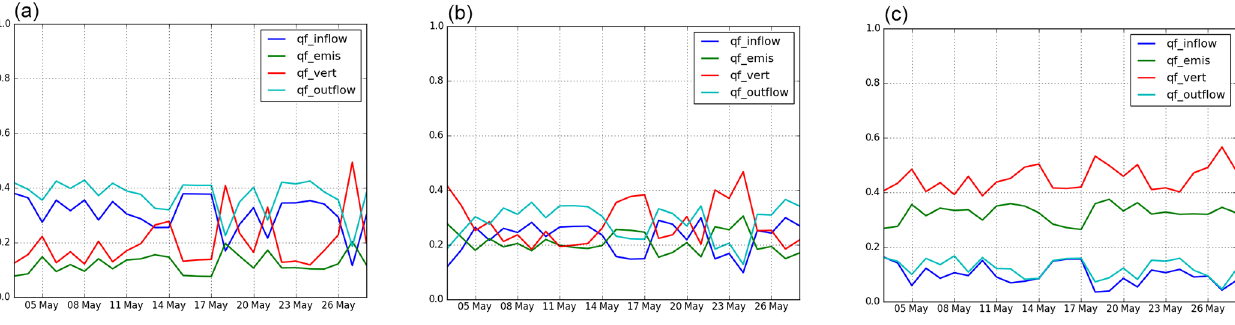
Figure 16. Normalized daily-weighted mass fluxes of NO 2 at BONAP (a) , CELES (b) and BP_EST (c) traffic stations: inflow advection mass flux (qf _inflow ) in blue, emissions (qf _emis ) in green, vertical mass flux (qf _vert ) in red, and outflow advection mass flux (qf _outflow ) in cyan. The fluxes are calculated as detailed in Eq. (18).